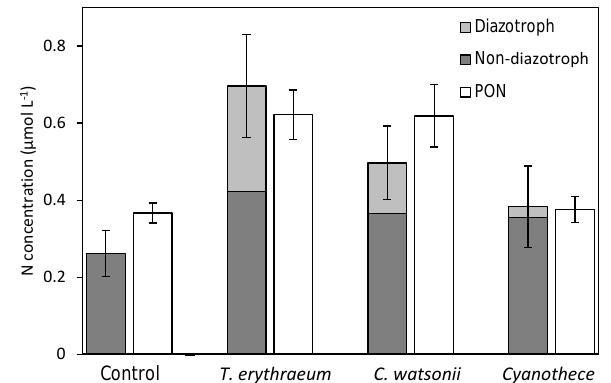
Figure 2. PON concentrations measured by mass spectrometry (EA-IRMS) and biomass associated with each plankton group in each treatment after 48h of incubation (µmolL − 1 ). Errors bar rep- resent the standard deviation on triplicate